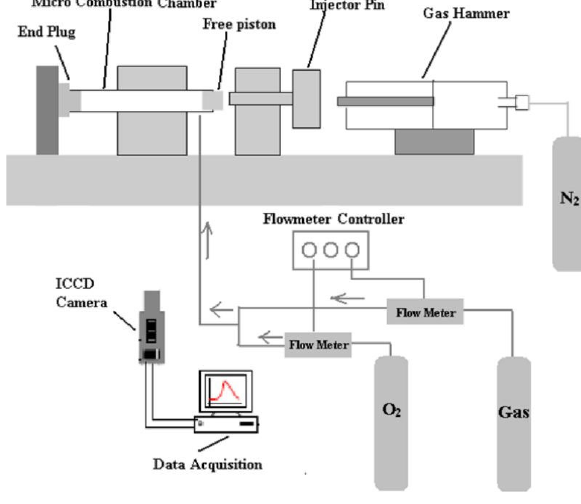
Figure 3. Schematic of the experimental system [8]. Table 2. The settings of the initial simulation conditions.